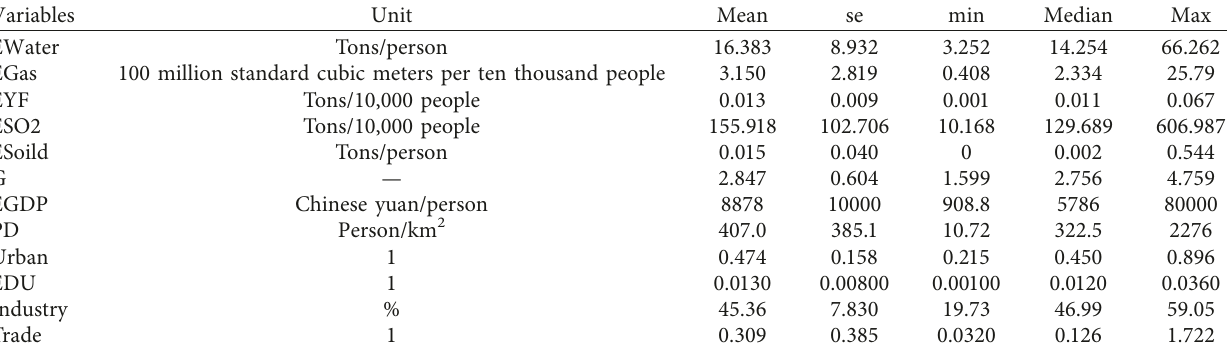
Table 2: Descriptive statistics of variables.